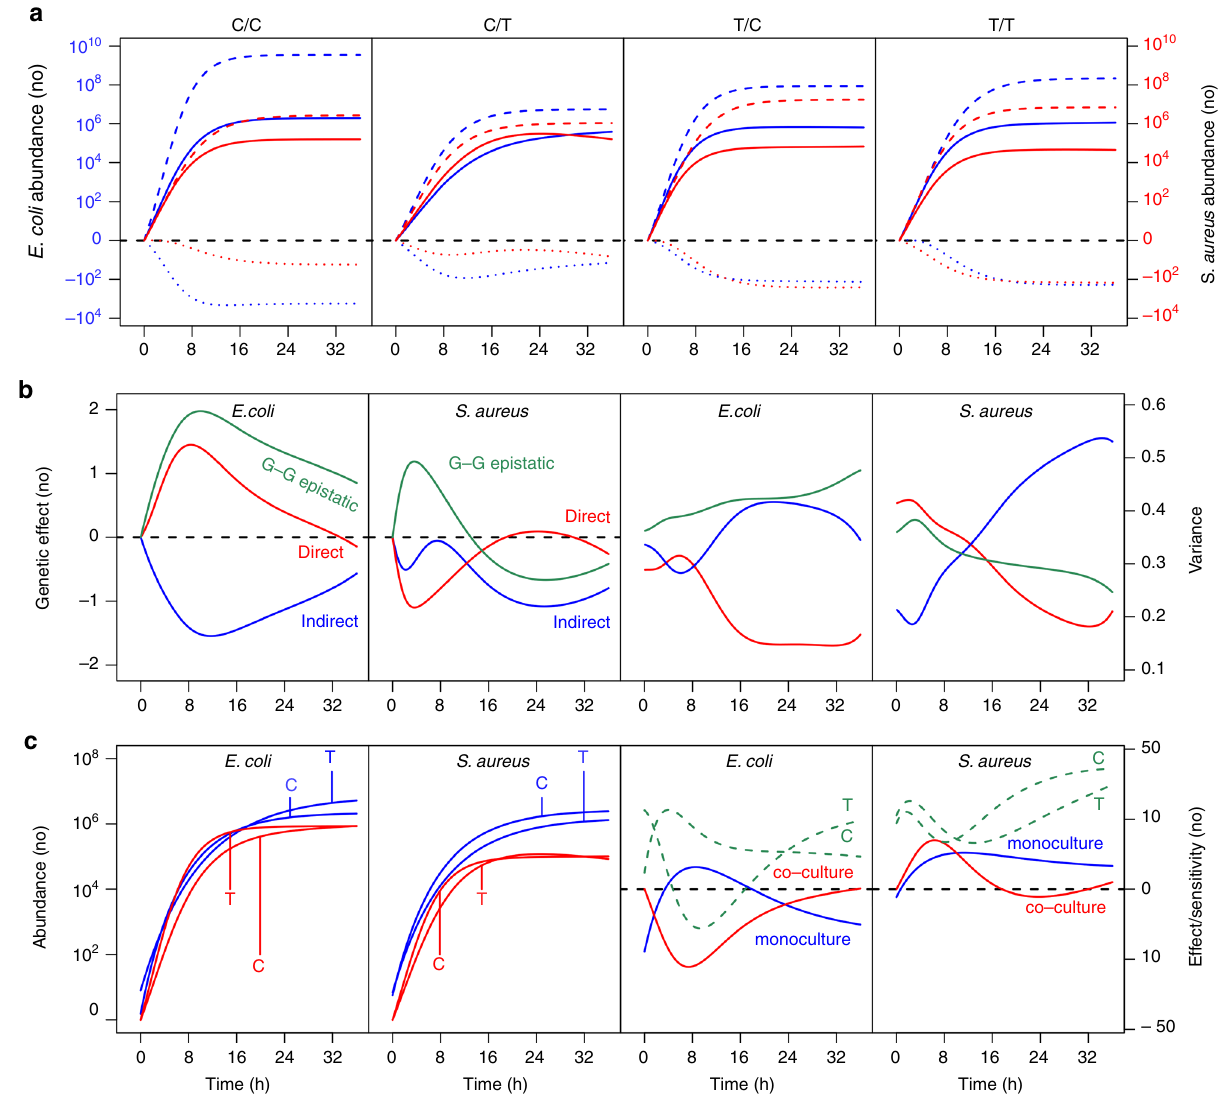
Fig. 4 Microbial growth curves of genotype combinations across different species in co-culture. a QTL E4614704 from E. coli and S188004 from S. aureus form four genotype combinations C/C, C/T, T/C, and T/T. The overall growth of microbial abundance (solid line) for each combination is decomposed into its independent (broke line) and interactive growth components (dot line) for E. coli (blue) and S. aureus (red). The interactive curves all are below the zero line, suggesting the negative effect one species exerts on its coexisting species. b The genotypic value of each genotype combination is partitioned into its direct (red), indirect (blue), and genome – genome (G – G) epistatic effects (green) on the growth of each species (the fi rst two plots from the left), with the time-varying proportions of the total genetic variance explained by each of these effects (the fi rst two plots from the right). c Comparison of microbial growth for the same genotype (C or T) at E4614704 from E. coli and the same genotype (C or T) at S188004 from S. aureus between co-culture (red) and monoculture (blue) (the fi rst two plots from the left). The genetic effect curves (solid cline) of the same QTL in co-culture (red) and monoculture (blue), as well as the allelic sensitivity curves (broke line) of the same genotype to different culture treatments, were calculated (the two plots from